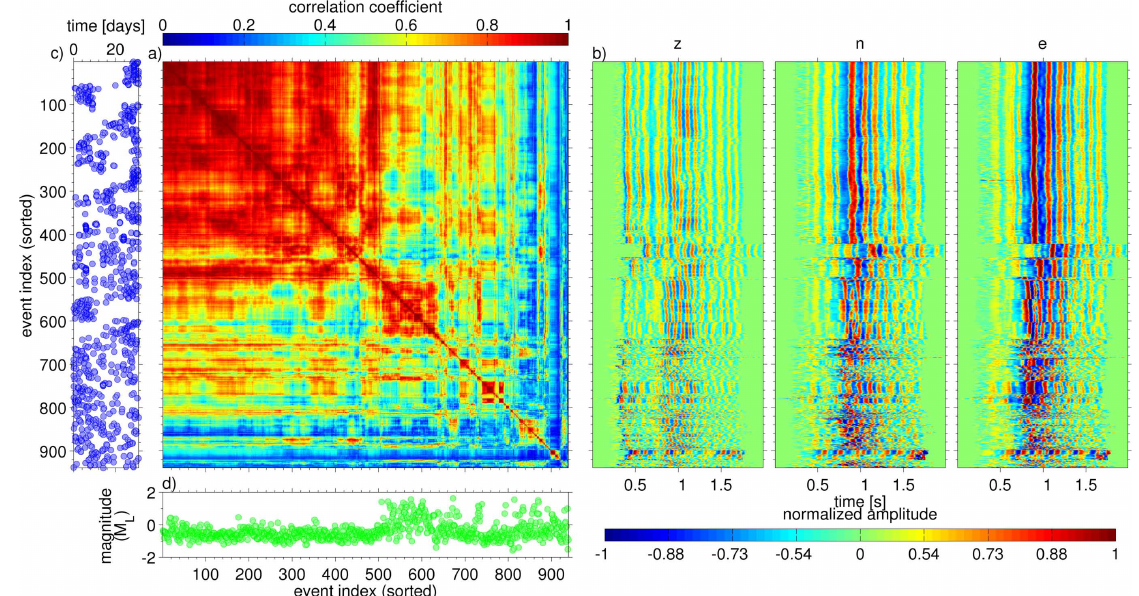
Fig. 5. Sorted similarity matrix (a) for station HM10 and October 2006 with the corresponding waveforms (components Z , N , E ) which have been correlated (b) . (c) and (d) provide additional information about time of occurrence and magnitude distribution respectively.